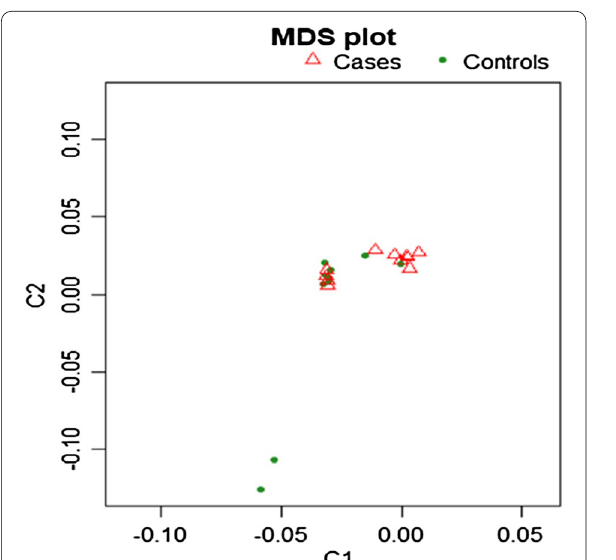
Fig. 1 MDS plot. The plot shows the genomic kinship between the analyzed subjects